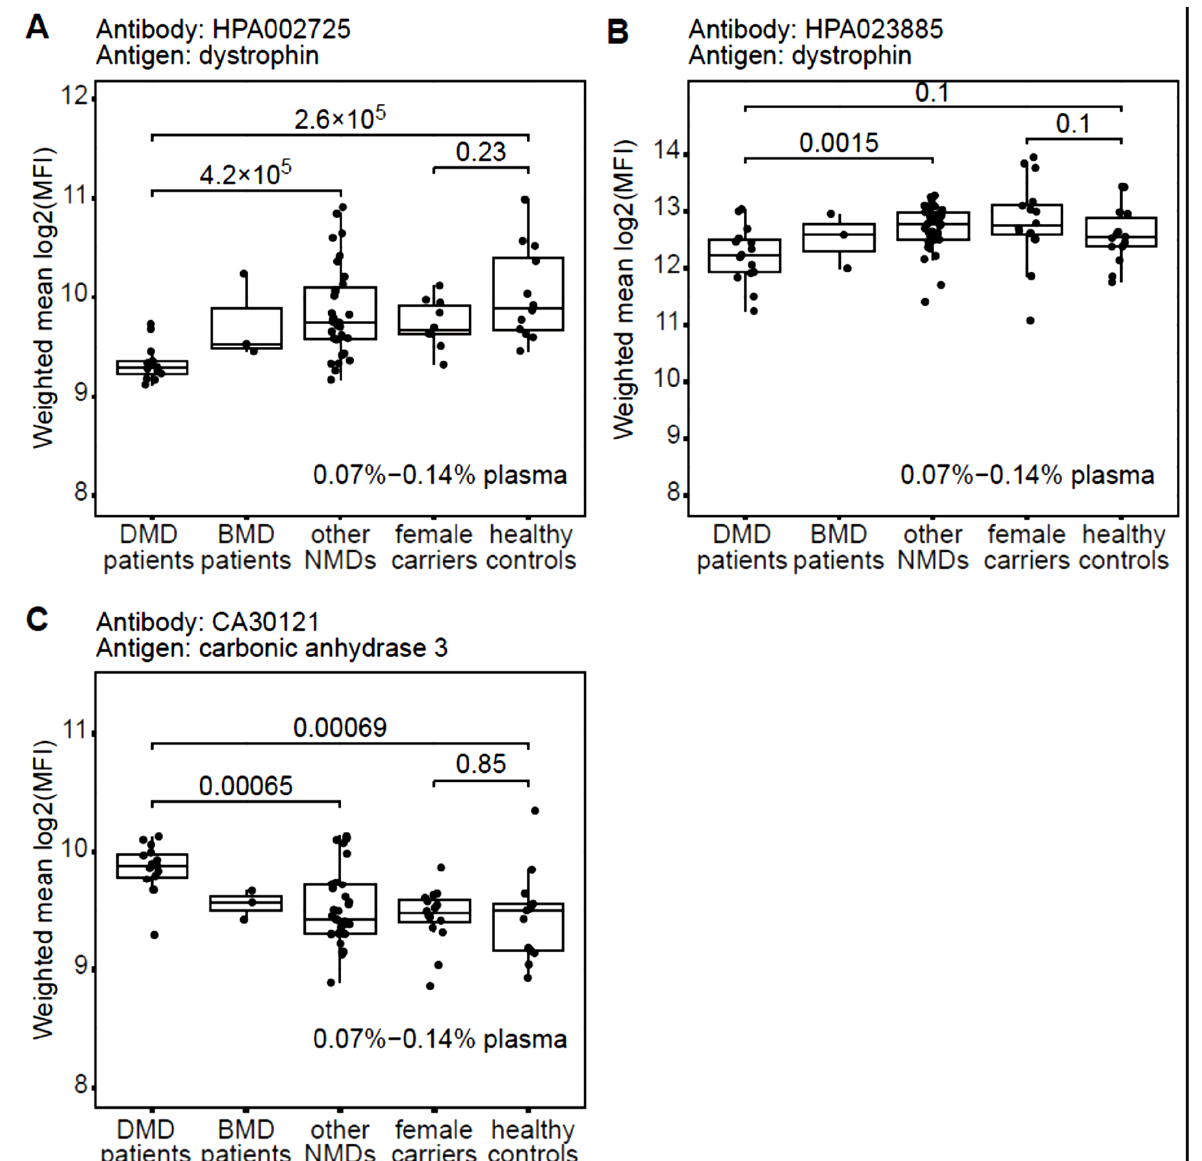
Figure 1. Dystrophin and carbonic anhydrase 3 detected in patient plasma cohort using antibody suspension bead array. An in ‐ house produced antibody suspension bead array was used to detect DYS protein ( A , B ) and carbonic anhydrase 3 ( C ) on plasma from 82 human donors: 16 DMD patients, 3 BMD patients, 33 patients with other neuromuscular disorders not characterised by mutations within the DMD gene, as well as 16 DMD female carriers and 14 healthy controls. A significantly ( p ‐ value < 0.05, Wilcoxon rank sum test) lower abundance of DYS was observed in DMD patients than all other patient groups when using the N ‐ terminally binding anti ‐ DYS antibody HPA002725 ( A ). In contrast, the C ‐ terminally binding anti ‐ DYS antibody HPA023885 ( B ) showed no significant difference between DMD and healthy controls. Carbonic anhydrase 3 ( C ) was used as a positive control showing an expected higher abundance in DMD compared to healthy controls, in line with previous studies. Batch effect was compensated with the R algorithm Combat and protein abundancies calculated as mean log2(MFI) over up to 3 replicates diluted at 0.07–0.14%